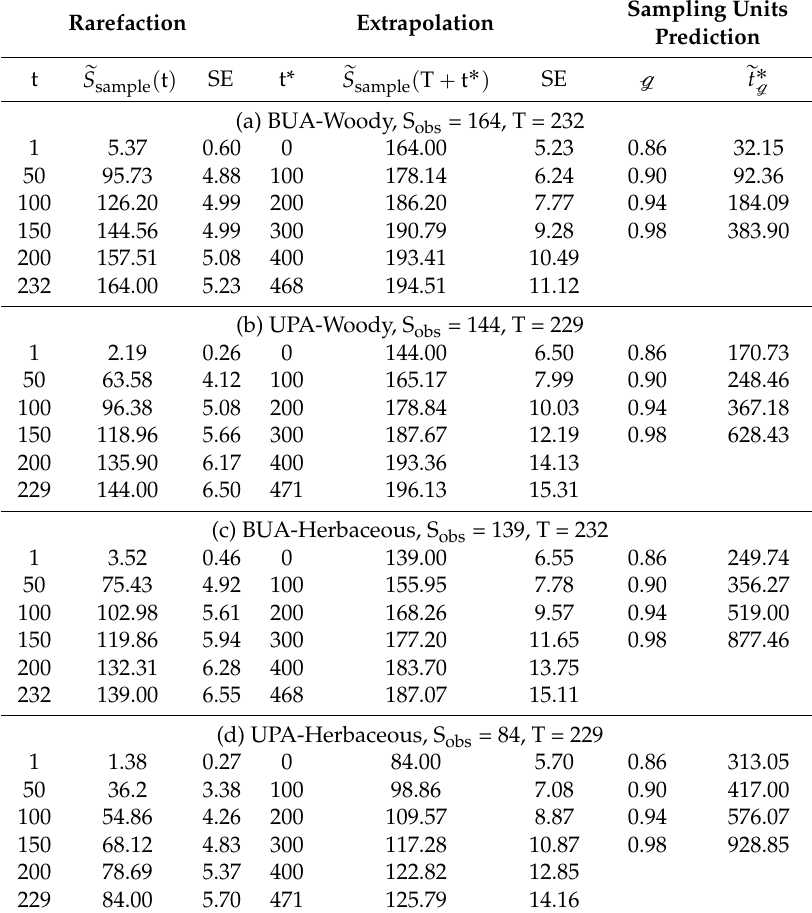
Table 4. Sample ‐ based interpolation, extrapolation and prediction of number of additional sampling units required to reach (cid:1845) (cid:4634) sample ( T + t* ) and (cid:1325) , under the Bernoulli product model, for woody and herbaceous plants in plots from the built ‐ up area (BUA) and the urban planning area (UPA).